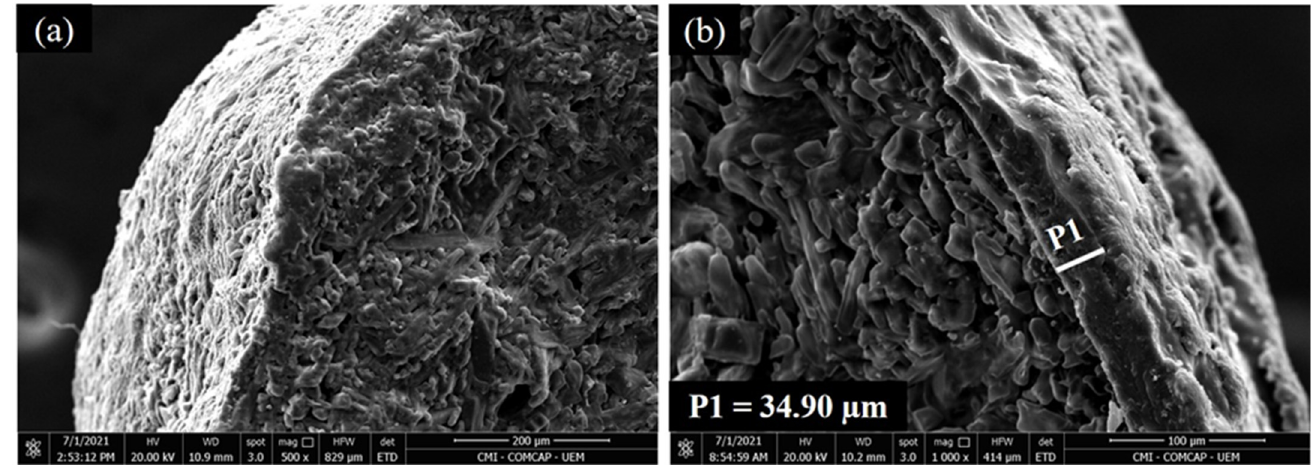
Figure 2. Electron micrographs of the separate Ur-NBPT + NI ( a ) and PCU granules ( b ). P1 is the thickness of the coating layer of the polymer coated granule.